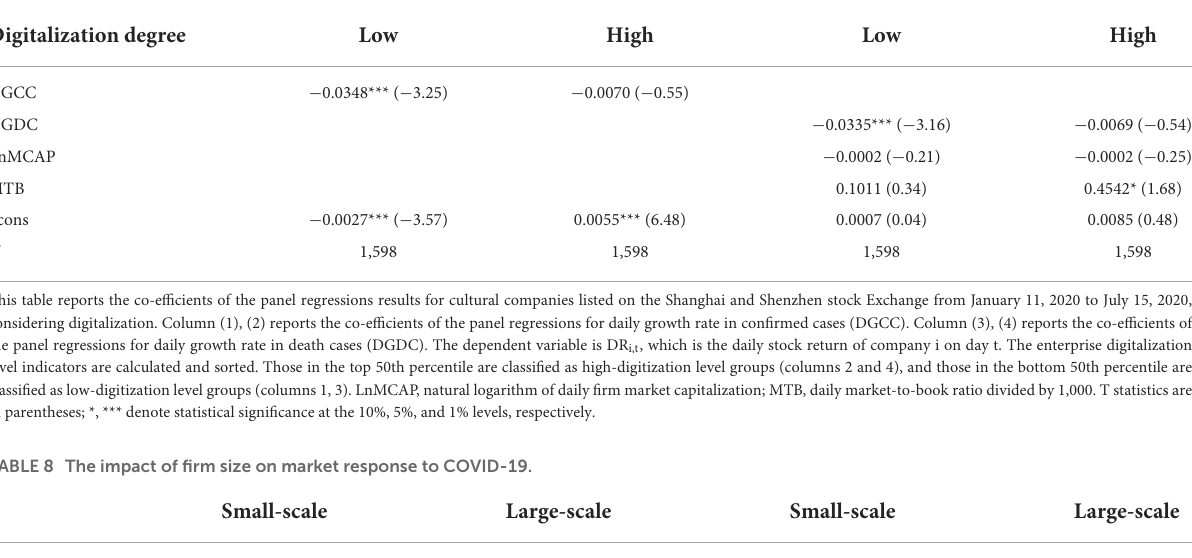
TABLE 7 The impact of firm digitalization on market response to COVID-19.